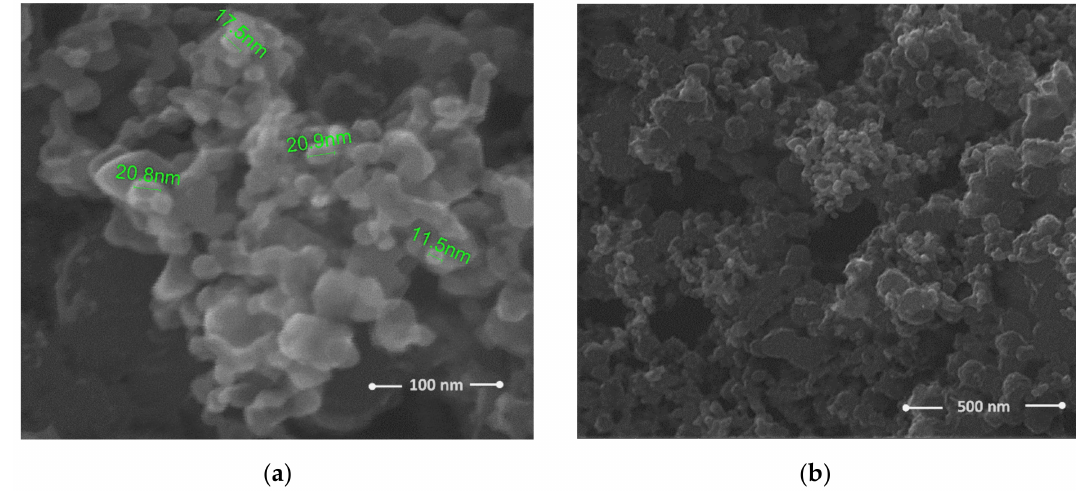
Figure 5. Scanning electron micrographs of the CNHox/TiO 2 /PVP at the 2:1:1 w/w/w ratio: ( a ) × 600,000 magnification and ( b ) × 150,000